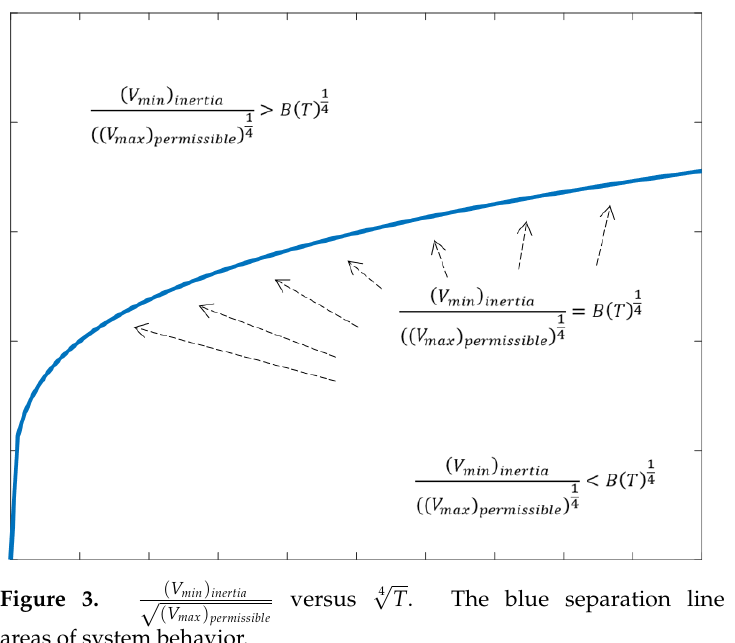
√ T . The blue separation line identifies two distinct Figure 3. ( V min ) inertia √ versus 4 ( V max ) permissible areas of system